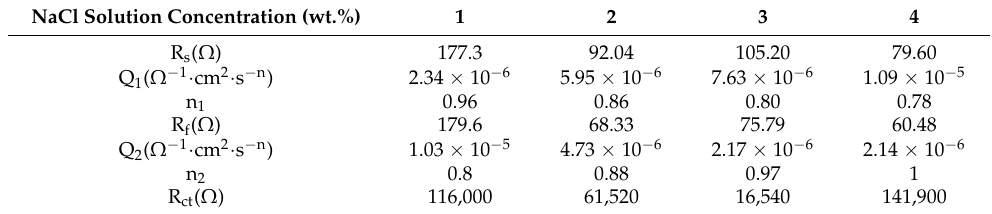
Table 4. Equivalent circuit element fitting parameters of 304L stainless steel in liquids with different NaCl